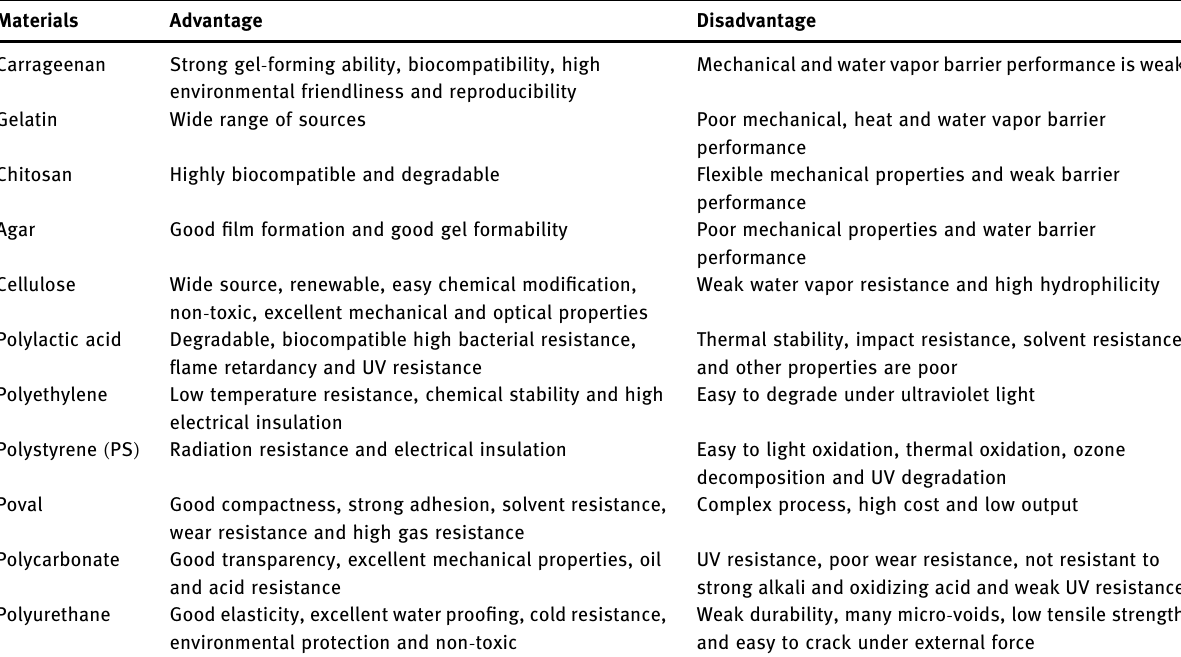
Table 2: Advantages and disadvantages of commonly used fi lm forming materials